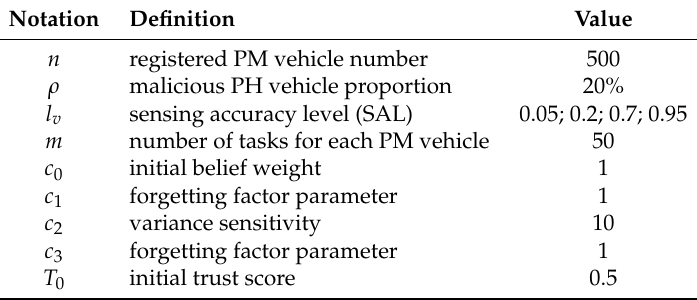
Table 1. Simulation Parameter